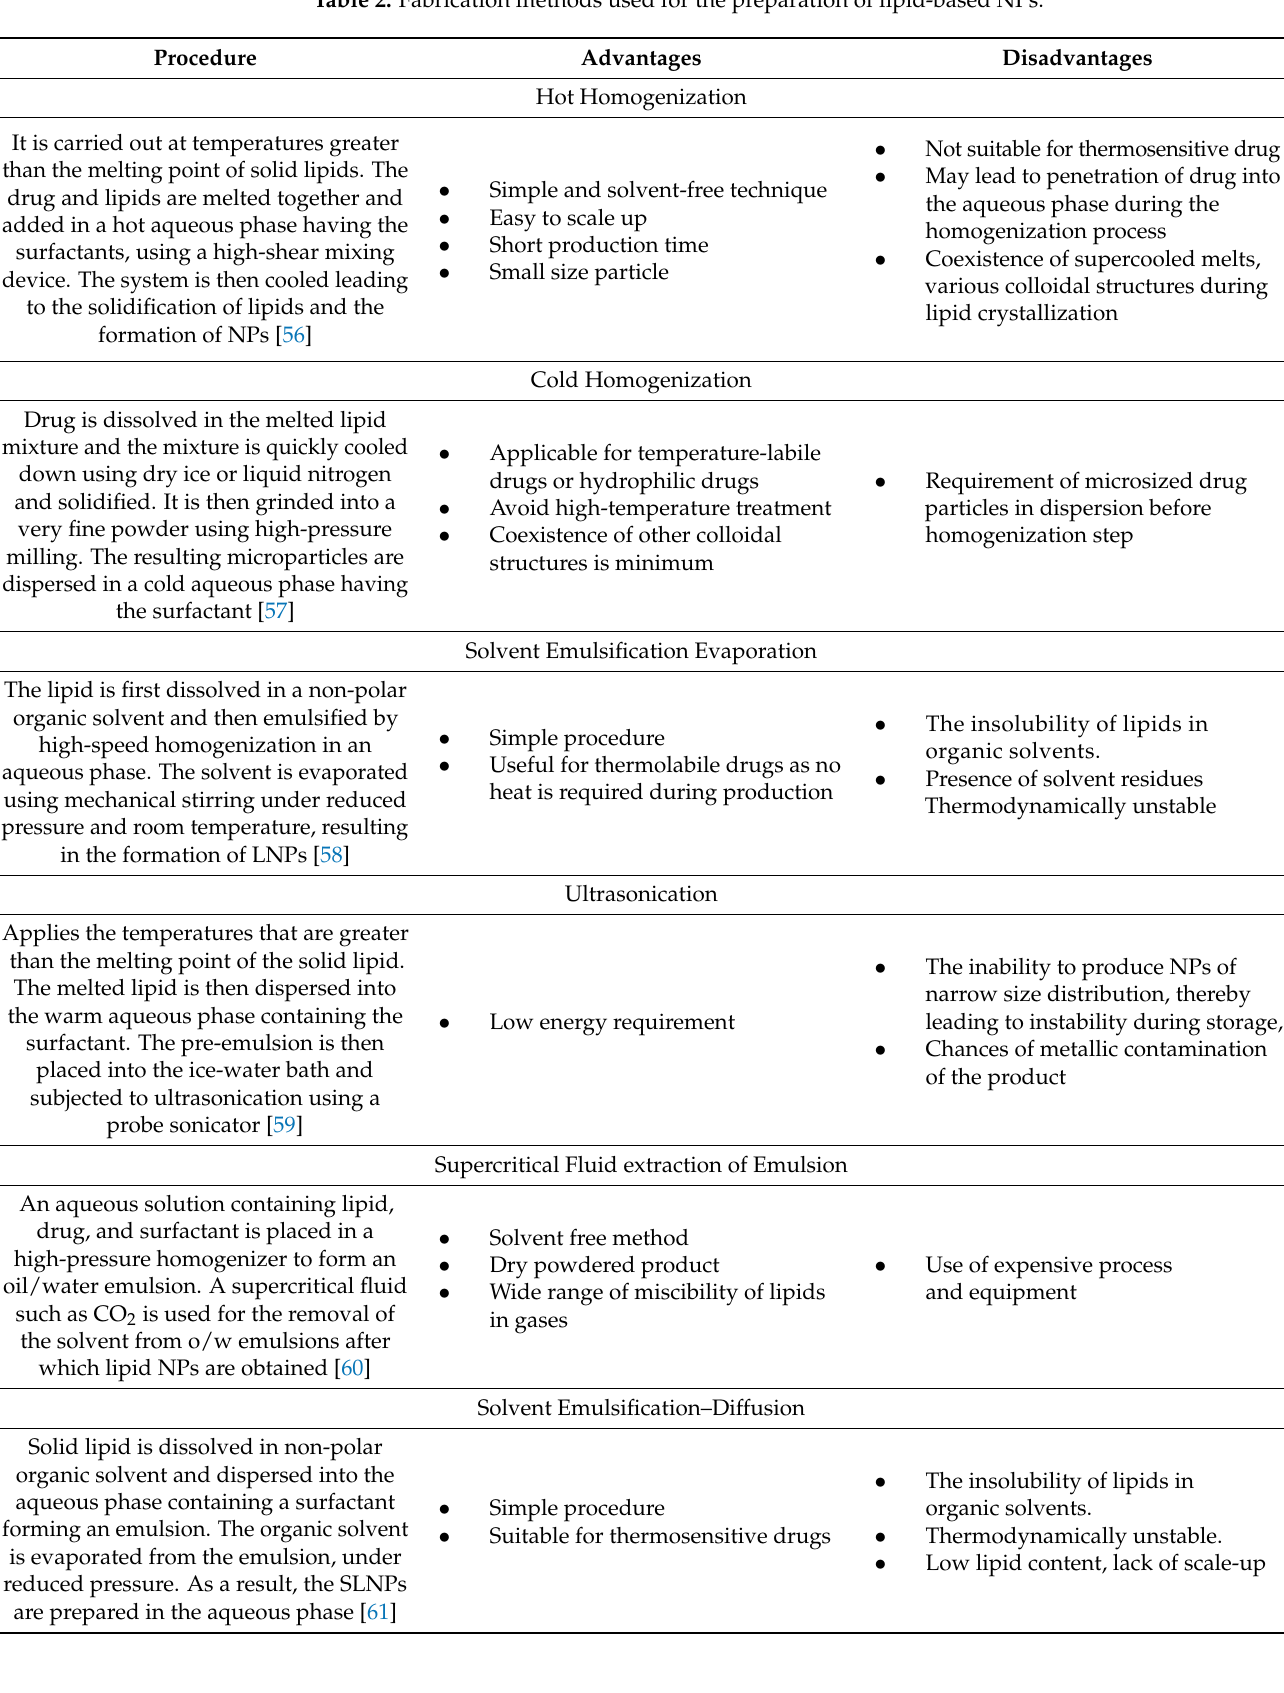
Table 2. Fabrication methods used for the preparation of lipid-based